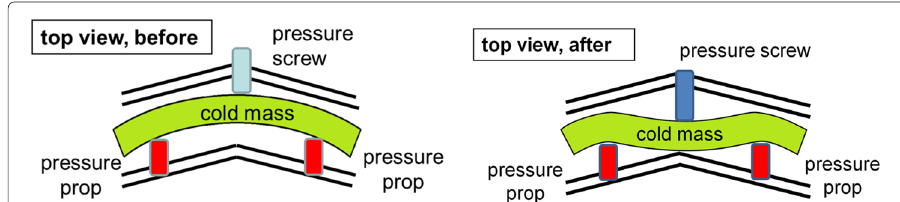
Fig. 8 Schematics of straightening. Left: Before applying the deforming force, Right: The deformation forces the pipe to develop two ‘camel humps,’ exaggerated in the figure for better illustration. This deformation yields the largest achievable horizontal aperture